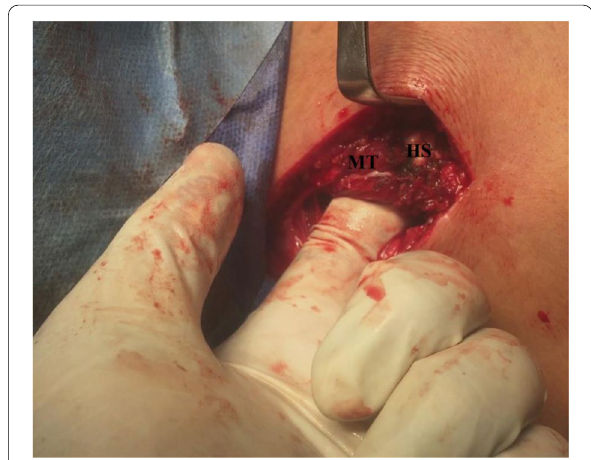
Fig. 12 demonstrate tested integrity of the tendon reconstruct by axial loading of the transferred middle trapezius tendon in the right shoulder; HS, hamstring sheet; MT, transferred middle trapezius tendon